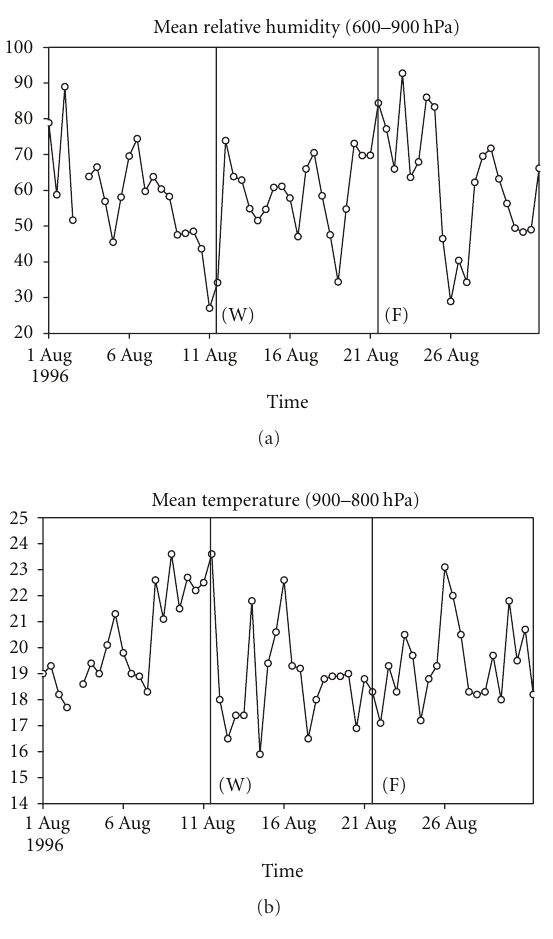
Figure 11: Mean time series of humidity between low and mid- levels (a) and of temperature over the low-levels (b) of the atmosphere in August 1996. The lines represent the passage of the non-developing AEW (W) and the AEW associated with Fran (F) troughs over Dakar station.